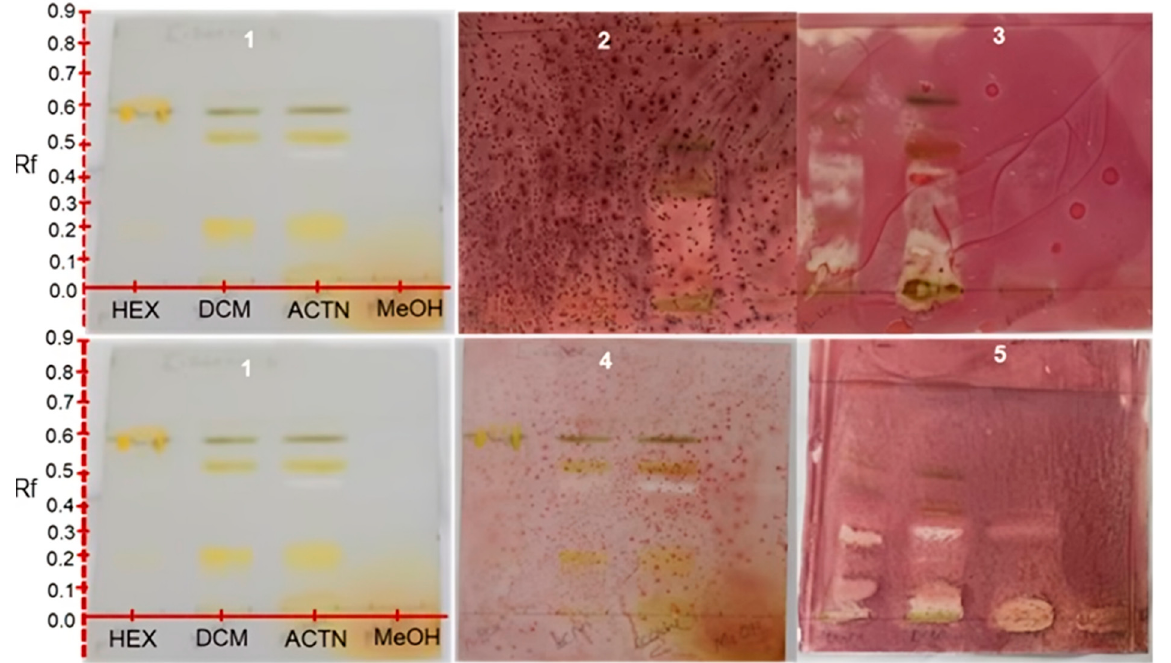
Figure 6. TLC direct bio-autography for the detection of antibacterial activity in 1 = Mistletoe tree extracts (control) antimicrobial activity against A. baumani BAA747 (plate 2), S. sense (plate 3), E. faecalis (plate 4) and B. substillis (plate 5). White coloration against purple background indicates inhibition against the test organism.